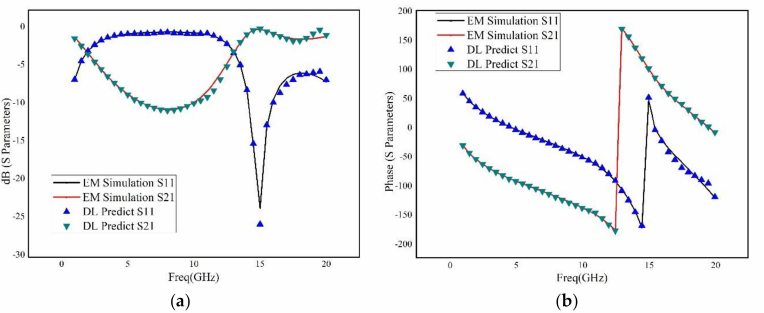
Figure 7. Results of the deep learning versus the EM simulation for non-uniformly sampling when a 2-hidden-layer neural network with 100 neurons on each layer is used. ( a ) dB of S Parameters. ( b ) Phase of S Parameters.